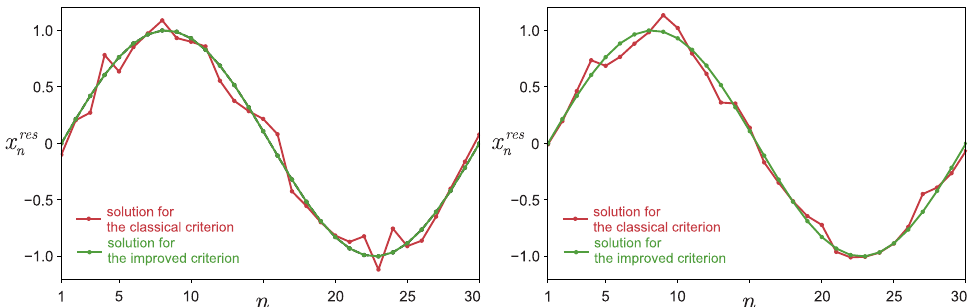
Figure 2. Example 1: Graph of x res n depending on the component index n . Figures correspond to two different arbitrary matrices A .